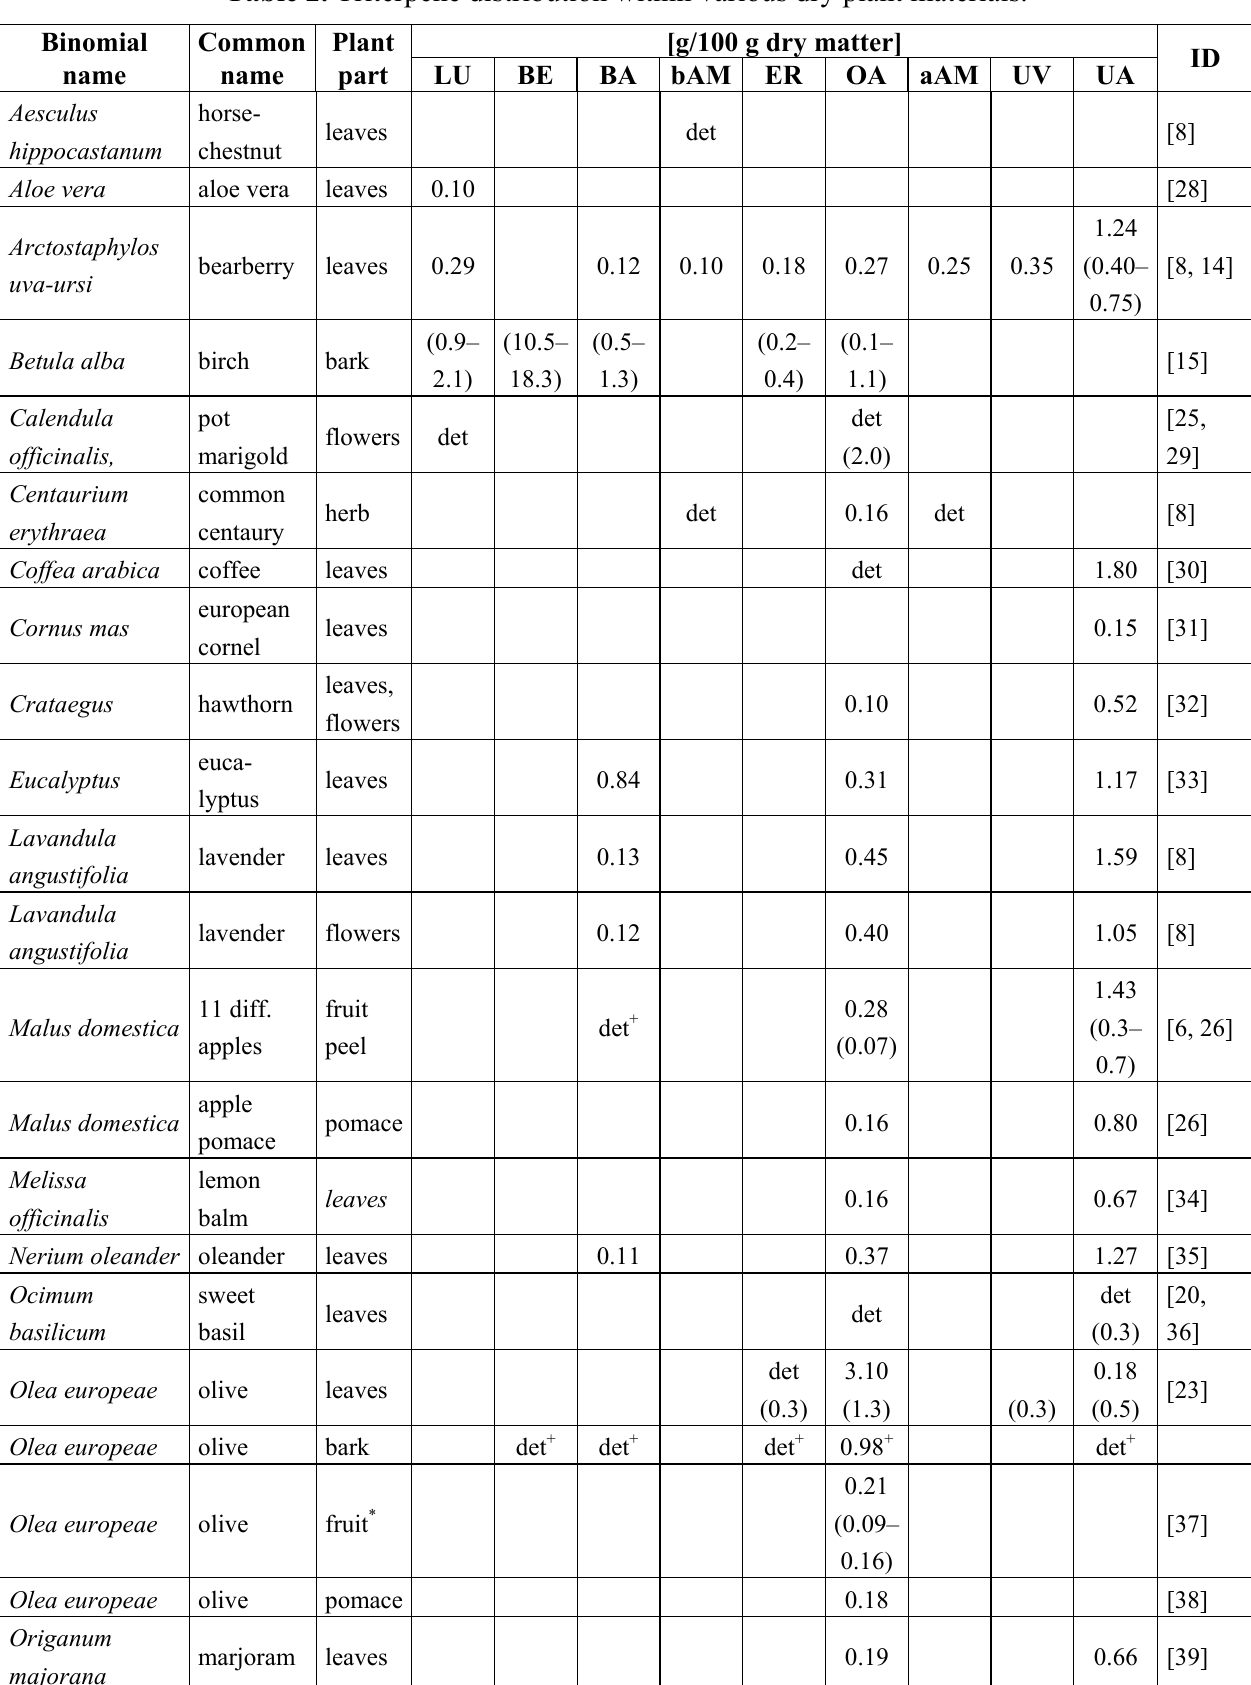
Table 2. Triterpene distribution within various dry plant